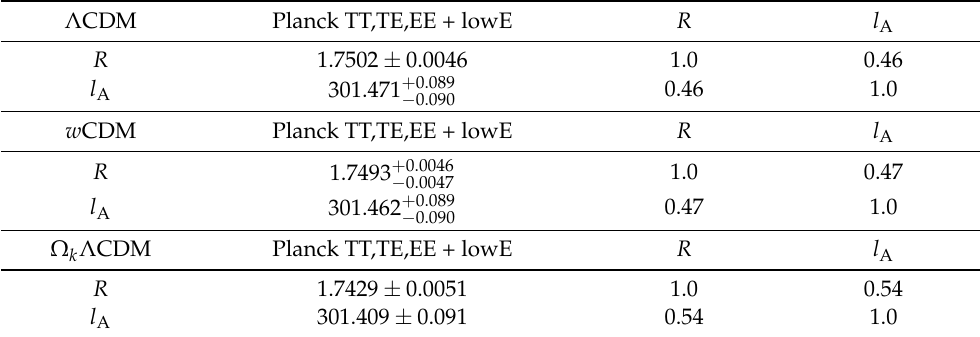
Table A2. The 68 % C.L. limits for R , l A , in different cosmological models and their correlation matrix for from Planck 2018 TT,TE,EE+lowE; see the text for